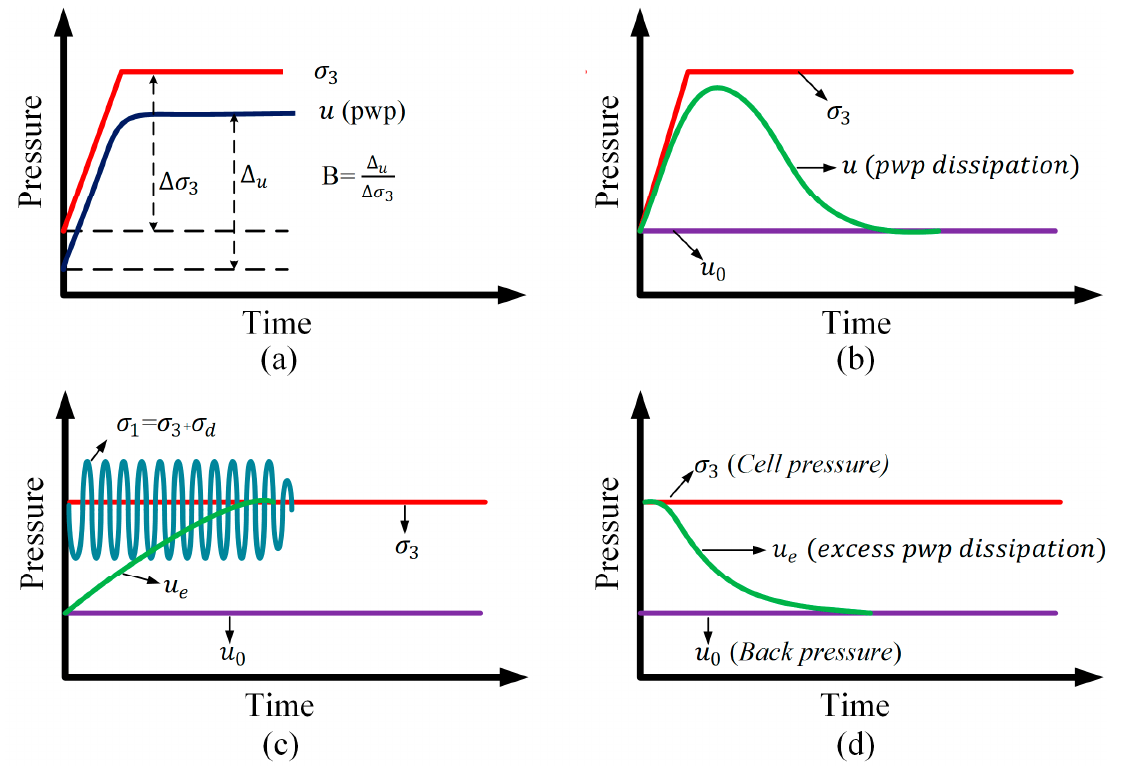
Figure 4. Schematic representation of test stages: ( a ) Saturation; ( b ) Consolidation; ( c ) Shearing; ( d ) Dissipation of excess pore pressures.